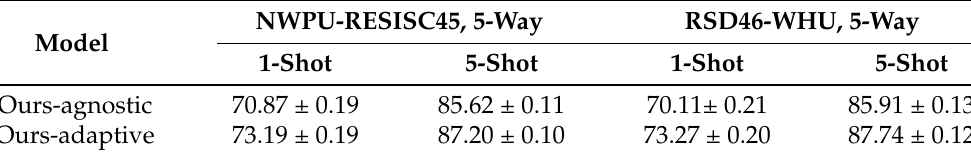
Table 7. Alation study of whether the embedding adaption module improves the performance of few-shot classification. Results are averaged over 10,000 test tasks with 95% confidence